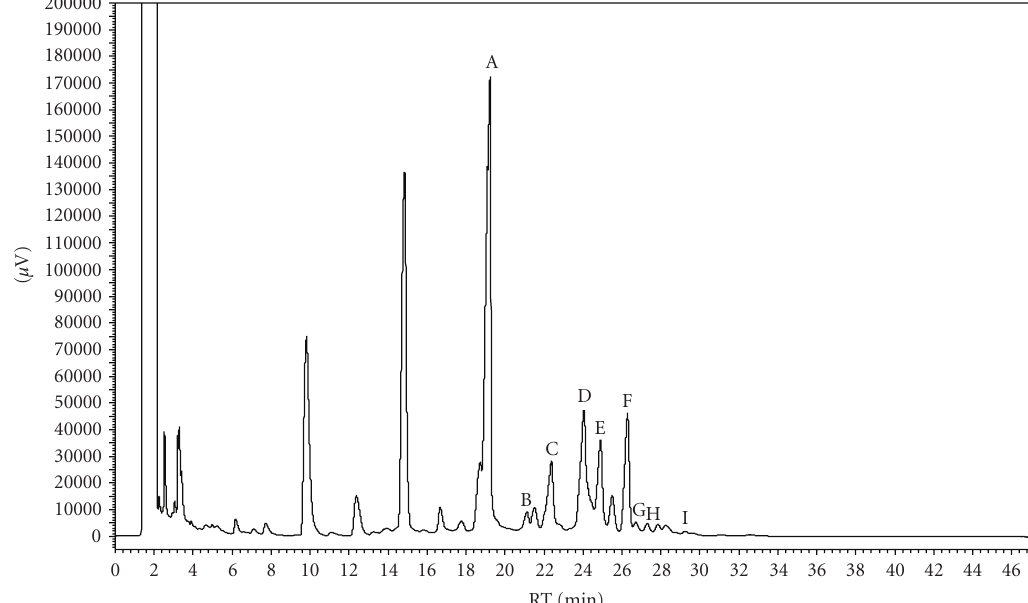
Figure 1: GC-MS analysis showed a mixture of monoterpenes, as the main compounds in essential oil leaves from Citrus limon.